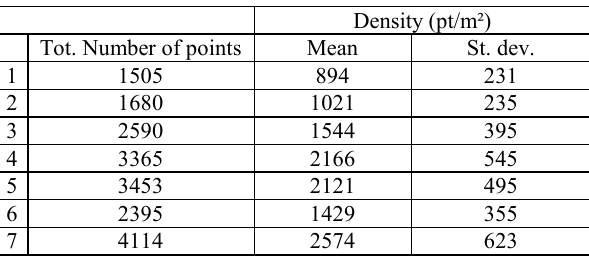
Table 3. Results of density analysis, Sample